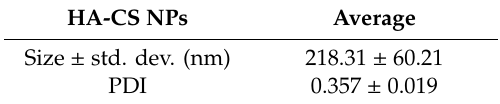
Figure 10. Hyaluronic acid-chitosan nanoparticle size (nm) distribution by number (%). Diameters were obtained in three readings (90 runs of 90 s). Table 5. Hyaluronic acid-chitosan nanoparticle (HA-CS NP) characterisation: mean particle size and polydispersity index (PDI).